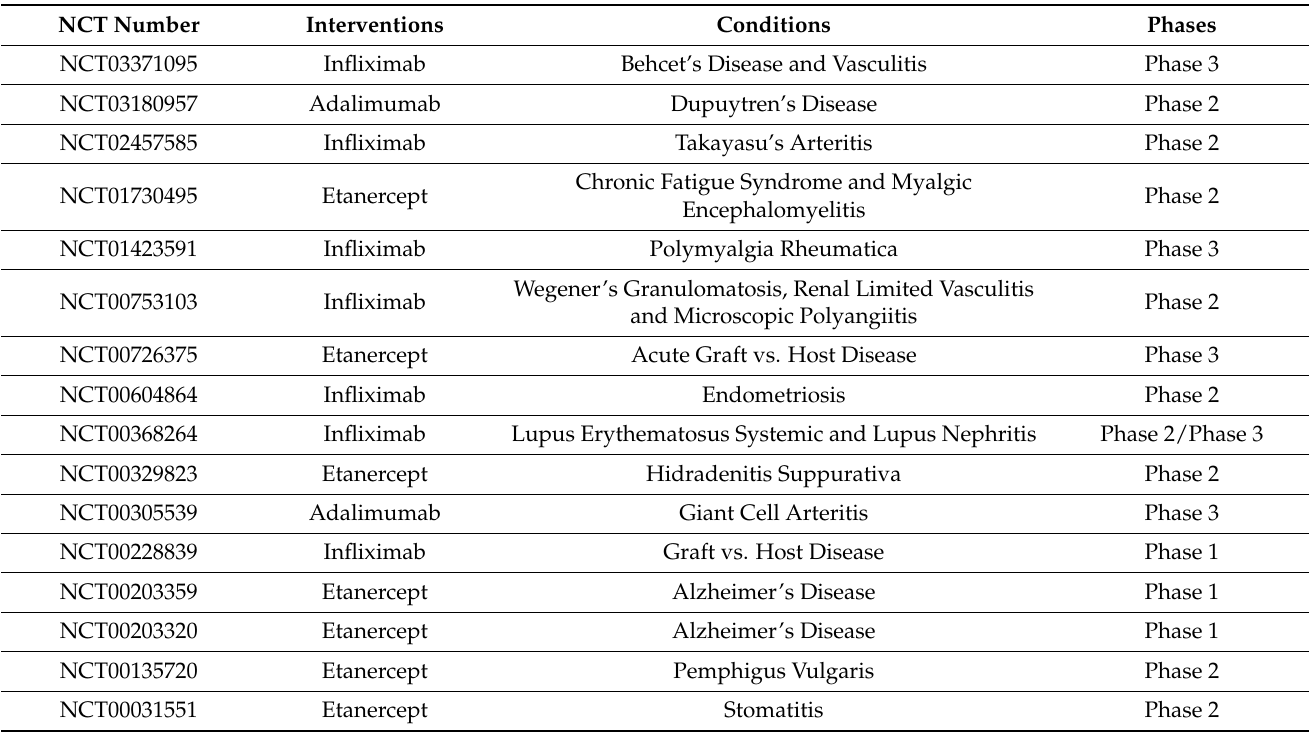
Table 1. Ongoing clinical studies on future applications of TNF- α blockers registered at https: //clinicaltrials.gov (accessed on 2 January